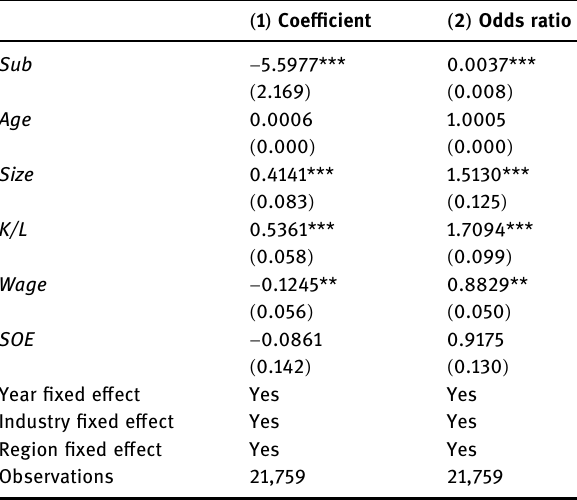
Table 12: Impact of fi scal subsidies on the probability of resurrec - tion of zombie fi rms ( Z2 standard )